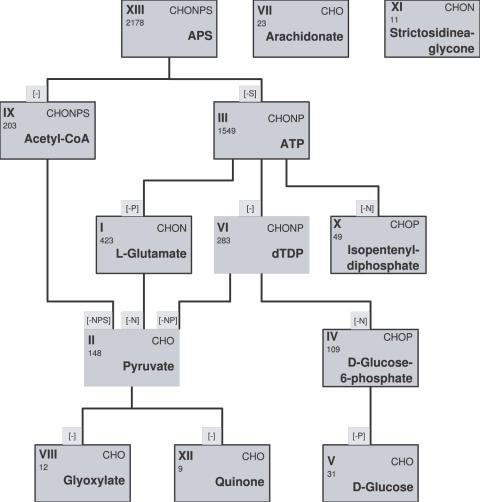
Hierarchy of compounds based on their biosynthetic potentials.Each box denotes a distinct consensus scope. On the top-left corner of each box, the cluster label and consensus scope size are shown. On the top-right corner, the chemical elements present in most cluster metabolites are given. Further, a representative metabolite of the cluster, whose scope is identical to the cluster's consensus scope, is given. Two consensus scopes are connected by an edge if the lower one is completely contained in the upper one. If the inclusion can be explained by differences in the chemical elements within the cluster members, the missing elements have been noted at the corresponding edge.